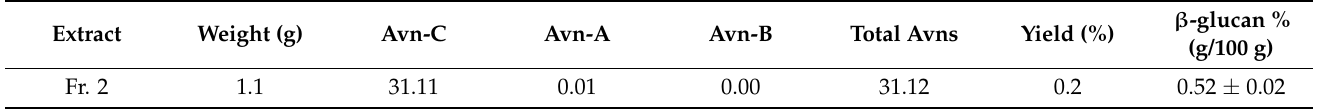
Figure 1. Procedure of Avn-C extraction. MN, methanolic extract; HPLC, high-performance liquid chromatography. Fr. 2, Avn-C-rich fraction; Avn-C, avenanthramide C; Avn-A, avenanthramide A; Avn-B, avenanthramide B. Table 4. Avn-C contents in Fr. 2 (mg/g).